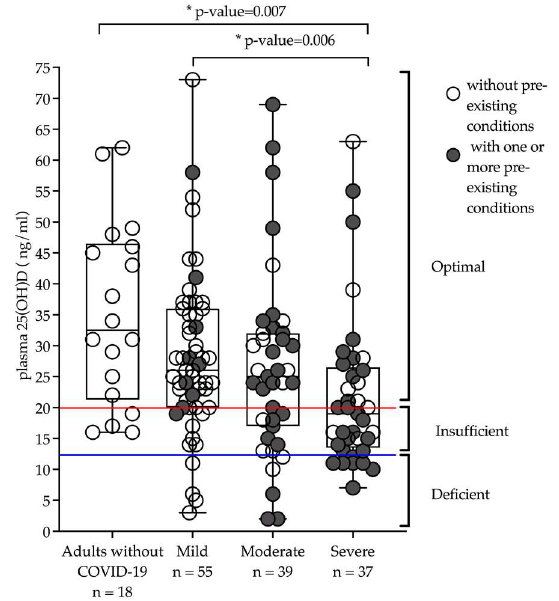
Figure 2. Plasma total 25(OH)D status was significantly different between participants with severe disease and those adults without COVID-19. Above the red horizontal line indicates optimal level, between the blue and red horizontal lines indicates sufficient, and below the blue horizontal lines indicates deficient. White circles indicate no co-morbidities/pre-existing chronic disease conditions, and grey circles indicate one or more co-morbidities/pre-existing chronic disease condition(s). Results were analyzed using SAS 9.4 (Cary, NC, USA). The * indicates significant total 25(OH)D p -value < 0.05.